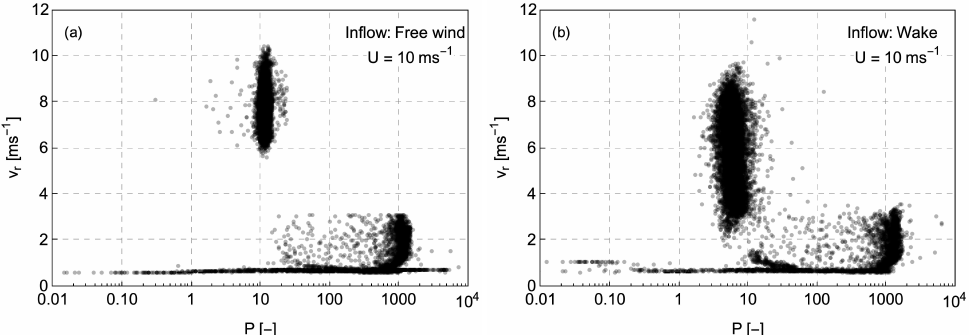
Figure 3. Scatter plots of the radial wind speed measurements acquired over a 10 min period versus the power of the corresponding Doppler spectra for two cases when the SpinnerLidar was measuring the inflow of: ( a ) the free wind and ( b ) a wind turbine wake. The mean wind speed was the same in both cases (U = 10 ms − 1 at 70 m). The values of P represent the power of the signal, i.e., the integrated intensity of the acquired laser Doppler spectra.